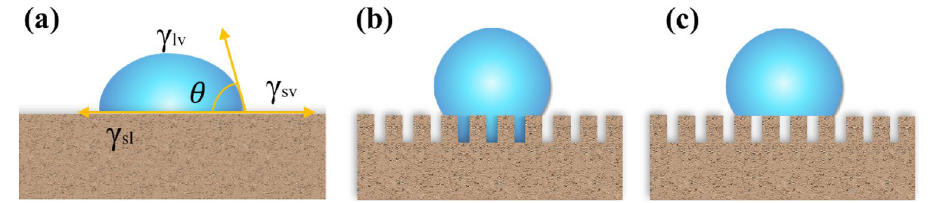
Figure 6. Schematic illustration of typical wetting behaviors of a droplet on a solid surface with and without roughness. ( a ) Young’s model, ( b ) Wenzel’s model, and ( c ) Cassie’s model.